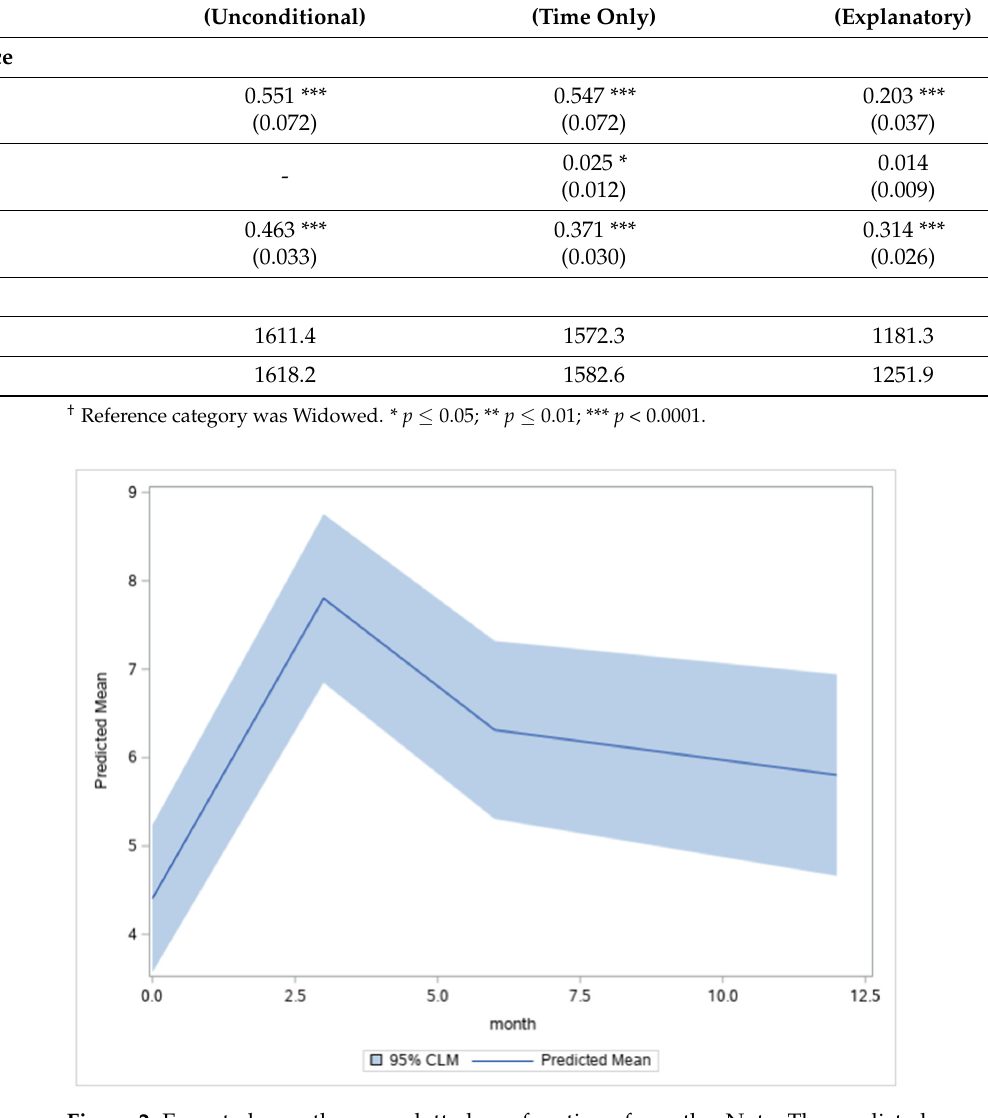
Figure 2. Expected growth curve plotted as a function of months. Note. The predicted means (and 95% Confidence Limits for the Mean) were: T0 = 4.41 (3.57, 5.24), T1 = 7.80 (6.85, 8.76), T2 = 6.31 (5.31, 7.32), and T3 = 5.80 (4.66, 6.94).